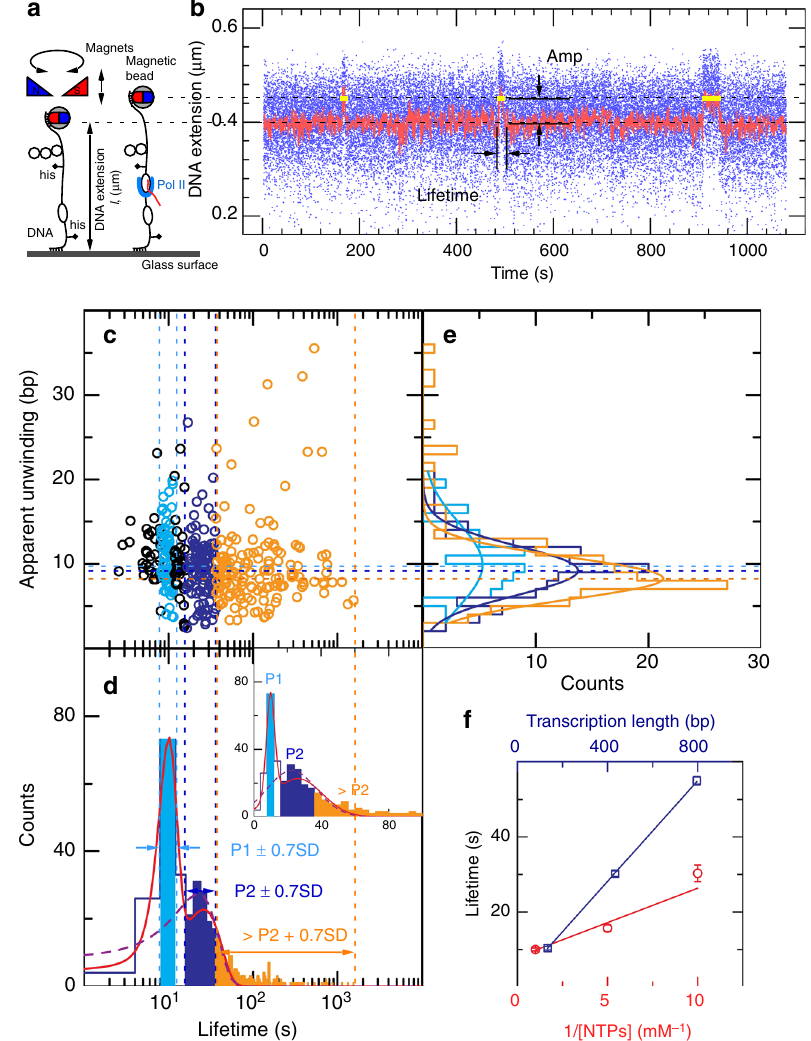
Fig. 1 Experimental validation of Pol II initiation, elongation, and termination. a DNA containing an unpaired 12-base bubble fl anked by Ec his terminators is tethered and torsionally constrained between a glass surface and a magnetic bead. b Time-trace obtained on negatively supercoiled Pol2-144-444-his construct shows the expected increases in DNA extension as small pulses, characterized by both their change in extension and their duration ( Δ l , Δ t ). Data were collected at 31.0802 Hz and all time traces were fi ltered at 0.5 Hz (red line). c 2D representation of transcription pulses re fl ecting their ( Δ l , Δ t ) coordinates ( N = 407 events). d Lifetime projection of the 2D plot scaled in log is fi t by a double-gaussian (red line, reduced chi-square is 0.75), yielding two peak durations: 10.0 ± 0.4 s (SEM) and 26.1 ± 1.6 s (SEM). Two sub-populations are selected based on the peak duration ± 0.7 SD: cyan, 10.0 ± 1.7 s (SD = 2.5 s for peak one); blue, 26.1 ± 10.1 s (SD = 14.5 s for peak two). Inset: linear scale of lifetime projection. The dashed violet line represents fi tting to a single-gaussian with a reduced chi-square of 4.57. e Amplitude projection of the 2D plot sub-populations is fi t to a single Gaussian (cyan line, giving a mean apparent unwinding of 9.9 ± 0.9 bp (SEM); blue line, 9.2 ± 0.3 bp (SEM); orange line; 8.3 ± 0.2 bp (SEM) in the blebbed bubble). f Dependence of the mean pulse lifetime on substrate length (blue) and inverse NTP concentration (red). Linear fi tting of the length-dependence data (blue line) to the model t = L / v + t L is the transcript unit length, v the velocity, and t v = 14.9 ± 0.4 bp/s and t = 1.3 ± 0.6 s. Nucleotide-dependence 0 , where 0 the intercept gives 0 data are fi t to a Michaelis – Menten model (red line) yielding af fi nity for NTPs K M = 230 ± 66 μ M and V max = 16.7 ± 2.6 bp/s. Error bars represent SEM; typically at least 200 events were collected for each NTP concentration. Source data are provided as a Source Data fi